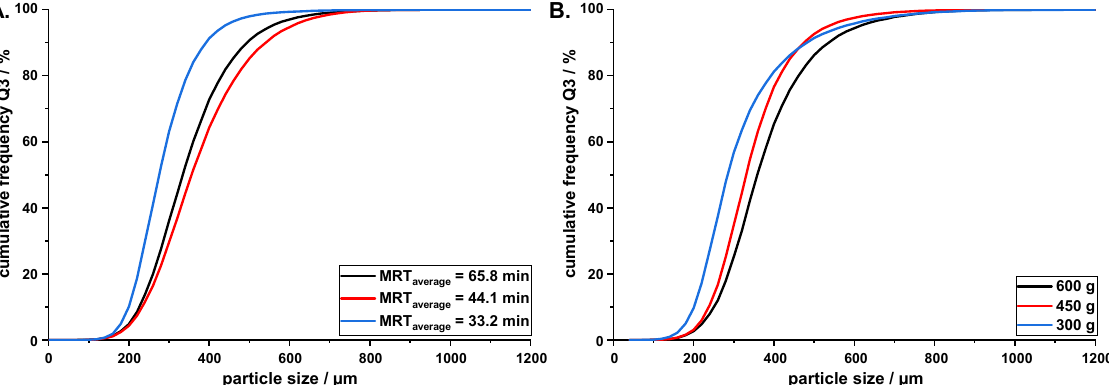
Figure 10. ( A ). PSD of QESD MF agglomerates produced at different MRTs by adjusting 𝑉(cid:4662) (cid:2925)(cid:2931)(cid:2930) at V 0 = 600 g; ( B ). similar average MRTs of ~33.5 min at otherwise constant conditions (350 rpm, 𝑉(cid:4662) (cid:2885)(cid:2900)(cid:2893) = 2.5 mL/min, 50 mL MF solution, n = 1, entire batch).